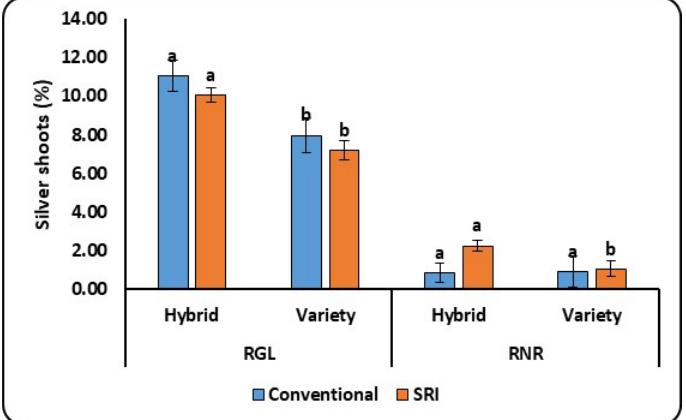
Figure 6. Gall midge incidence with different methods of rice cultivation. Means with the same letter are not significantly different by Tukey’s HSD ( p = 0.05) at each location Brown planthopper incidence was observed at three locations, with the highest numbers seen in the variety grown with conventional methods at Siruguppa (965/10 hills) followed by the hybrid with conventional methods (350/10 hills). In the other two locations (JDP and WGL), brown planthoppers were found to exceed the economic threshold level only with conventional methods in both the hybrid and variety plots. With SRI methods, brown plant hoppers were nil or less than 10 per hill (Table 1). At Warangal, the incidence of white ‐ backed planthopper was high with conventional methods (40/10 hills), and nil with SRI methods. Between hybrid and variety plots, the numbers of hoppers were not significantly different. Table 1. Planthopper (BPH and WBPH) incidence with different methods of rice cultivation. Cultivation Methods BPH Number per 10 Hills